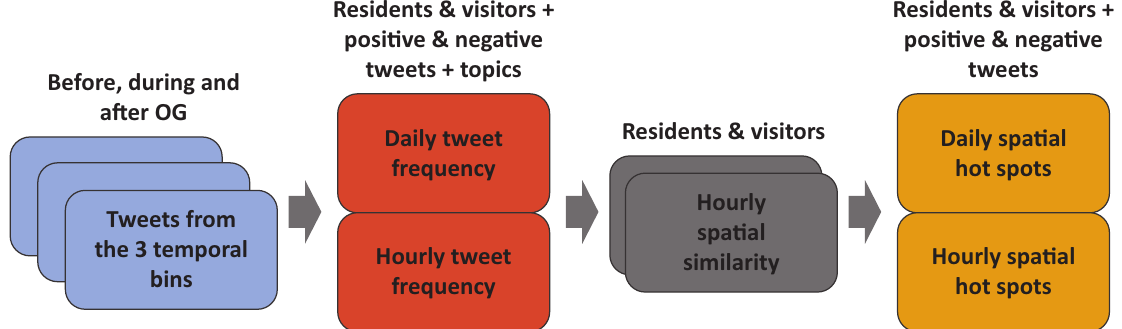
Figure 2. Spatiotemporal data processing